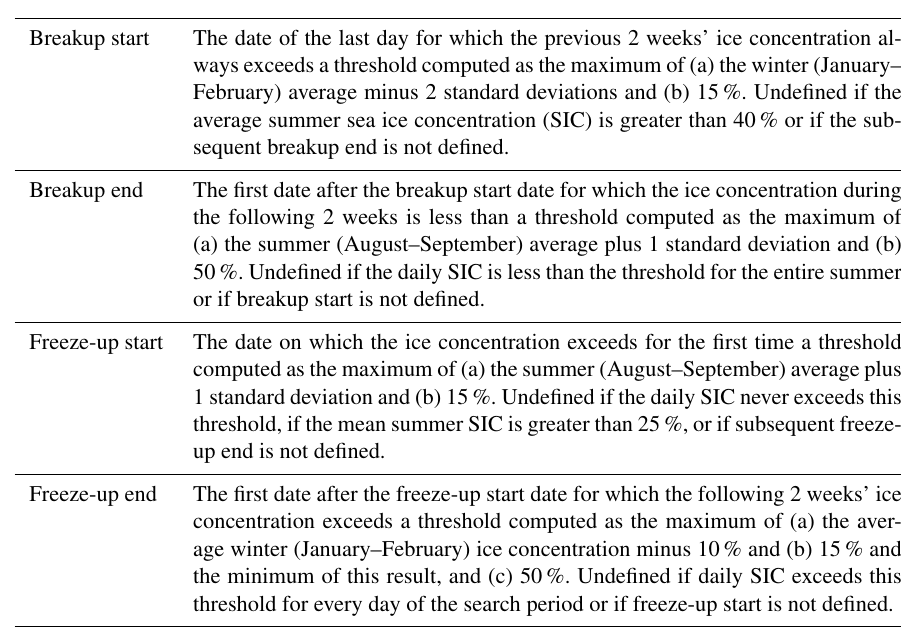
Table 1. Definition of the start and end of breakup and freeze-up.